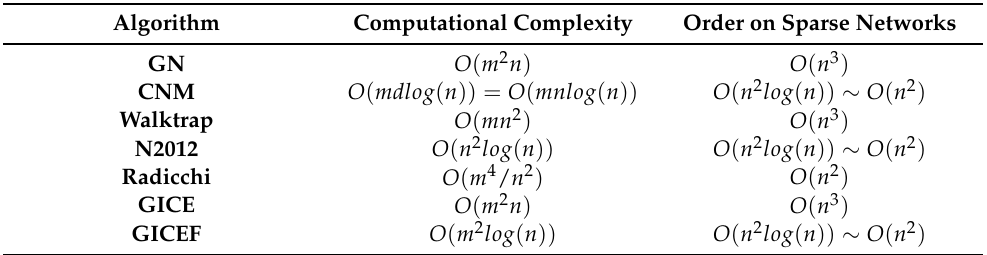
Table 1. Computational complexity of the GN, CNM, Walktrap, N2012, Radicchi, GICE and its fast version (GICEF)